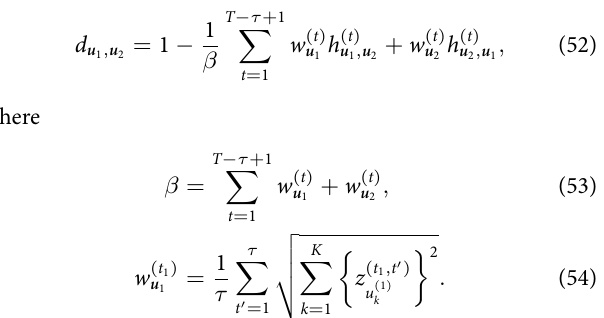
FIGURE 5 | Numbers of comparisons for Experiment 1.